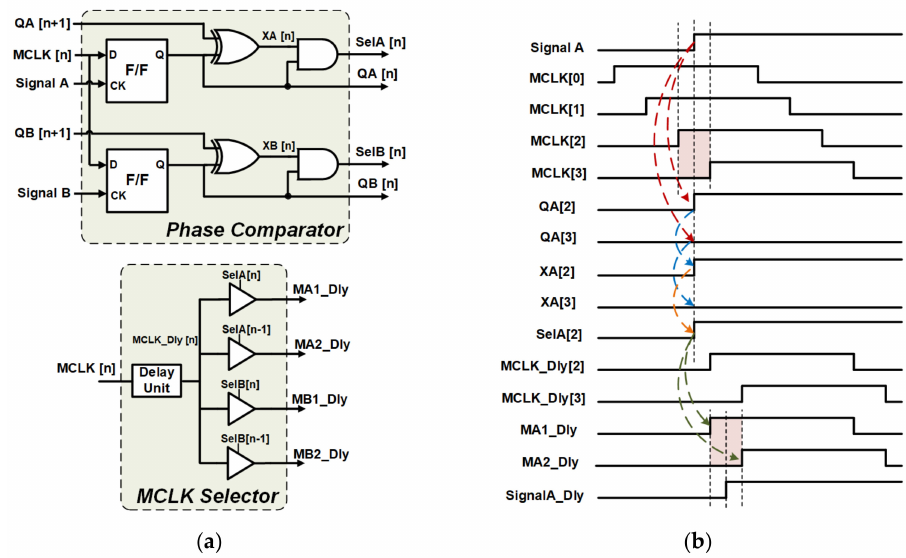
Figure 7. ( a ) The circuit diagram of phase comparator and MCLK selector; ( b ) Operation waveform of phase comparator and MCLK